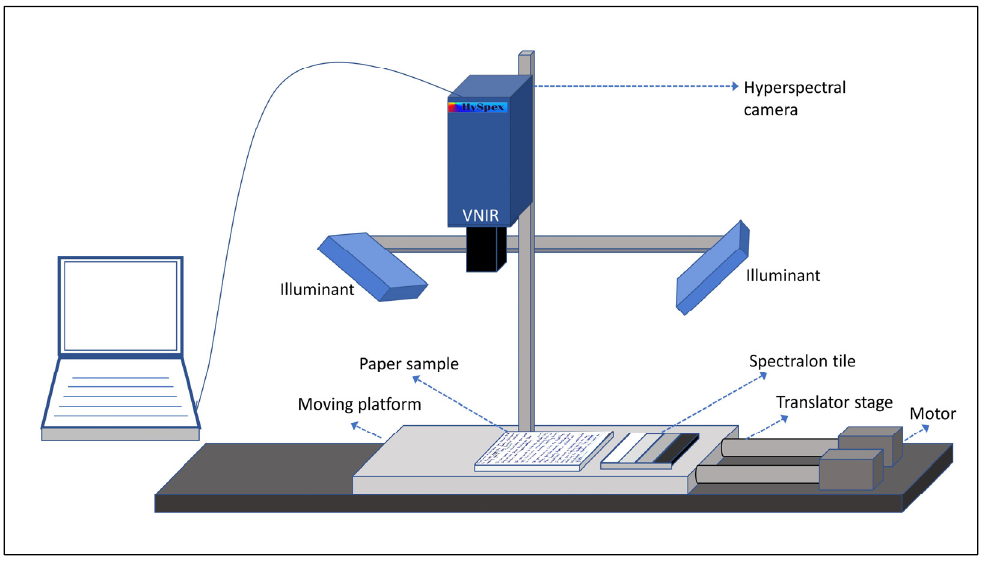
Figure 2. Hyperspectral acquisition setup.